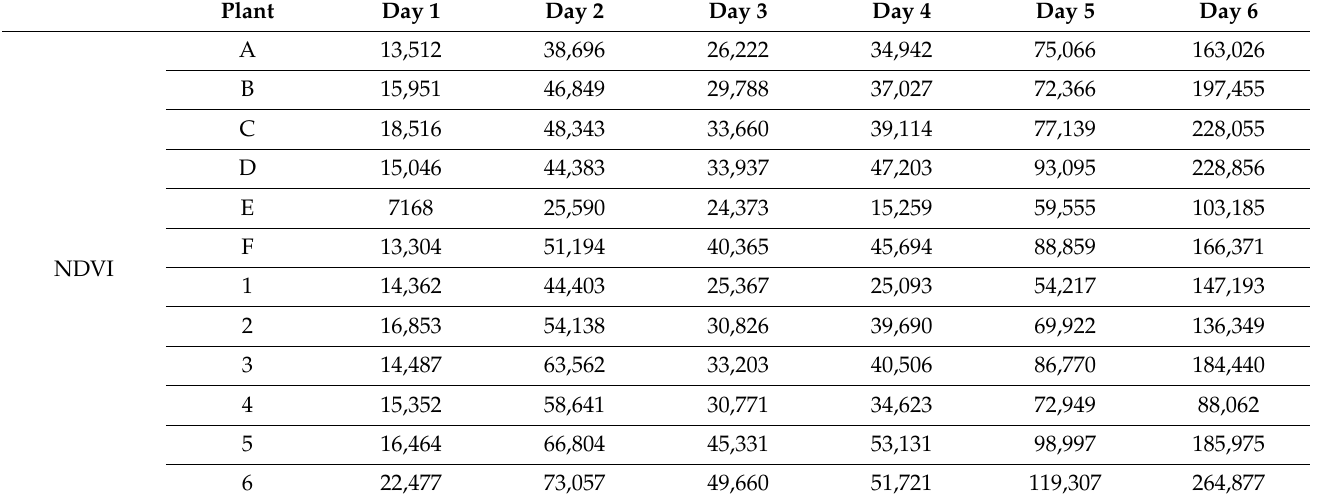
Table 1. NDVI and NGBVI quantification analysis results per